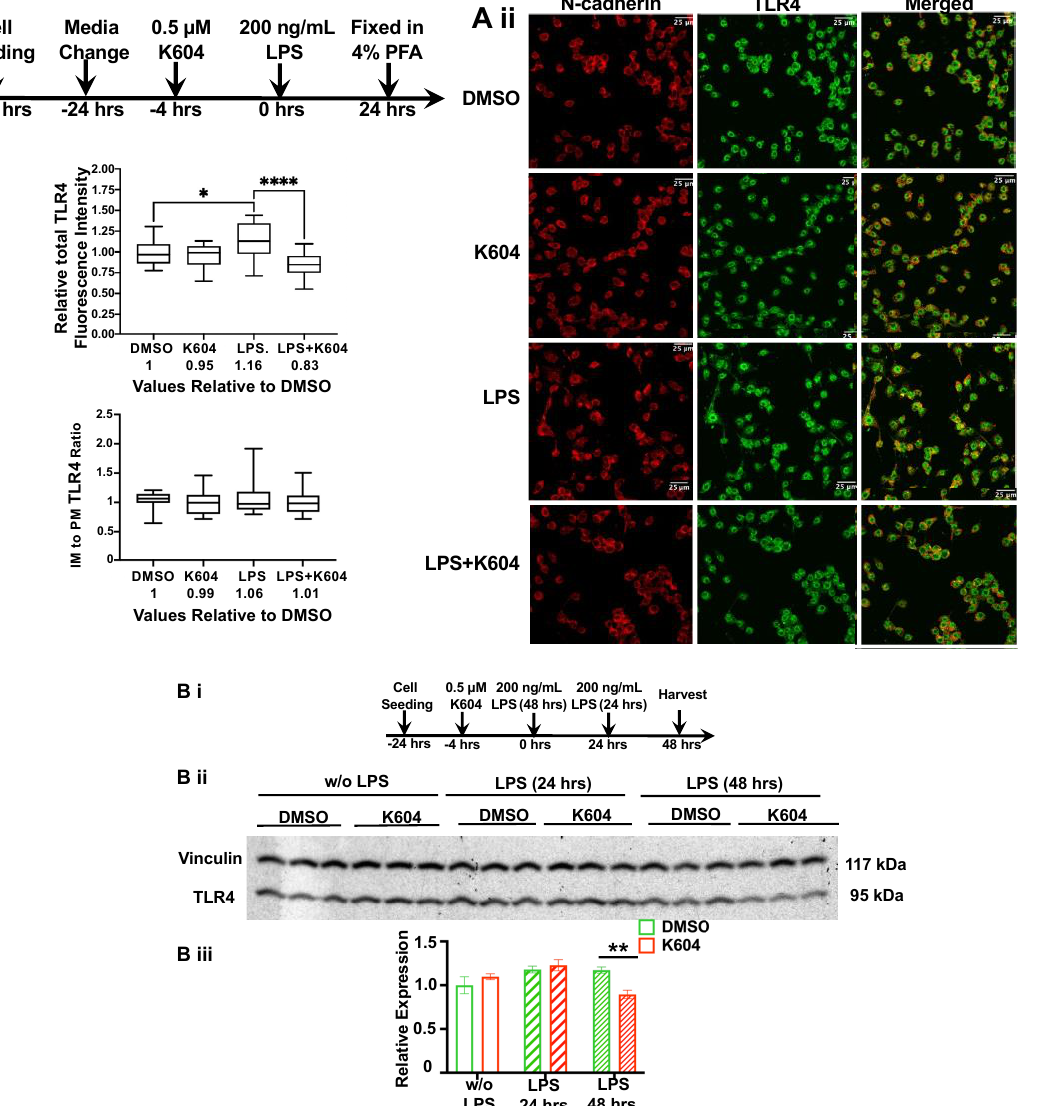
Figure 6. A1B decreases TLR4 protein content in microglia chronically treated with LPS. ( A ) N9 cells seeded at 1 × 10 5 cells per well on poly-d-lysine-coated glass cover slides in 6-well plates were pre-treated for 4 h with DMSO or with 0.5 µM K-604, then exposed with or without 200 ng/mL LPS for 24 h. Double immunofluorescence staining for TLR4 and for the plasma membrane marker N-cadherin was then performed. (i) Timeline of the experiment. (ii) Representative images demonstrating TLR4 distribution in N9 cells. (iii) Quantification of total TLR4 relative fluorescence intensity per cell, n = 15 cells/treatment group. (iv) Quantification of IM/PM TLR4 fluorescence intensity ratio. A total of 15 cells per group were analyzed. The TLR4 signals overlapping with that of N-cadherin are considered as TLR4 at the PM, while those not overlapping are considered as TLR4 at the IM. ( B ) N9 microglial cells were seeded at 2 × 10 5 cells per well onto 6-well plates in RPMI-1640 with 10% serum. N9 cells were treated with DMSO (control group) or 0.5 µM K-604 for 4 h, then treated with or without 200 ng/mL LPS for 24 and 48 h. At different time points, cells were harvested for protein isolation and TLR4 Western blot analyses. n = 3 replicates. Vinculin was used as the protein loading control. (i) Timeline of experiment. (ii) Western blot. (iii) Quantitation of Western blot. * p < 0.05; ** p < 0.01; *** p < 0.001; **** p < 0.0001. This result combined with the results shown in Figures 4 and 5 suggested that in cells acutely treated with LPS, A1B causes TLR4 at the PM to be endocytosed at a